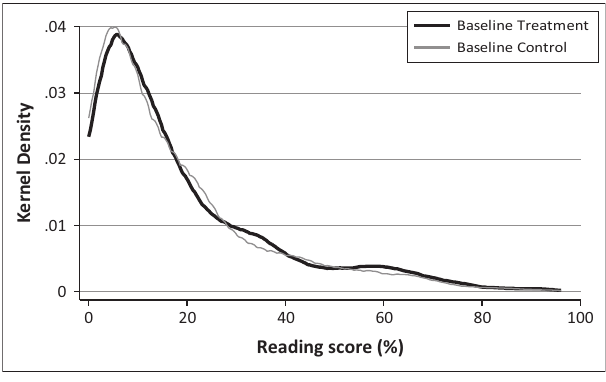
FIGURE 1: Kernel density of pre-test scores,